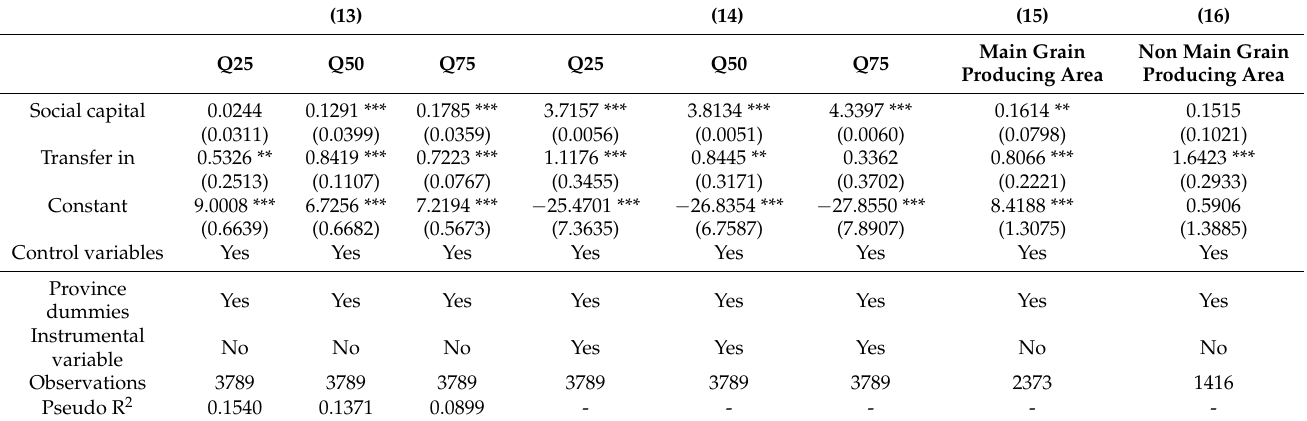
Table 4. Discussions on individual heterogeneity and regional